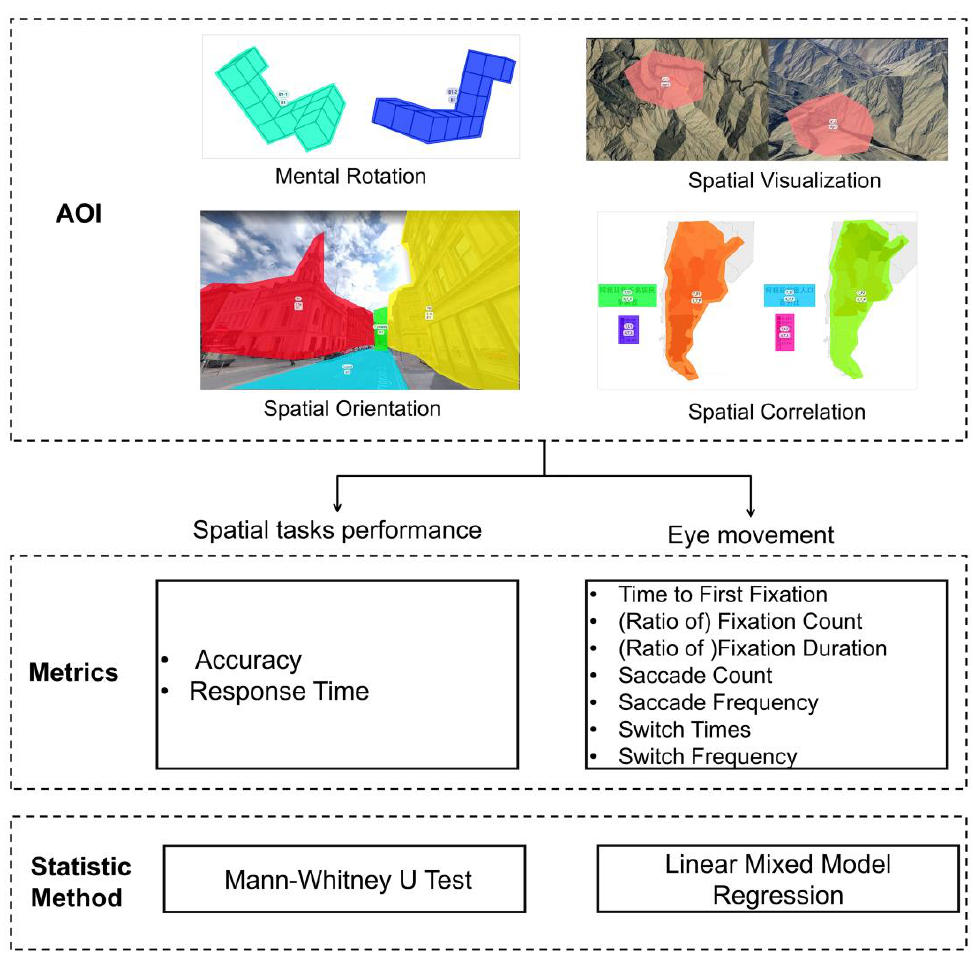
Figure 3. Analysis Figure 3. Analysis framework.